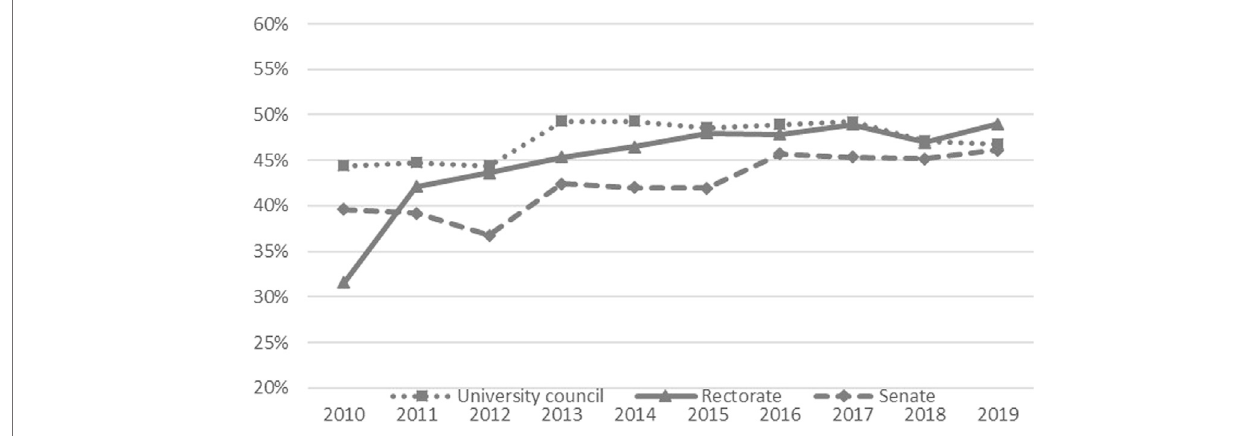
FIGURE 1 | Share of women in rectorates, senates, and university councils 2010 - 2019.